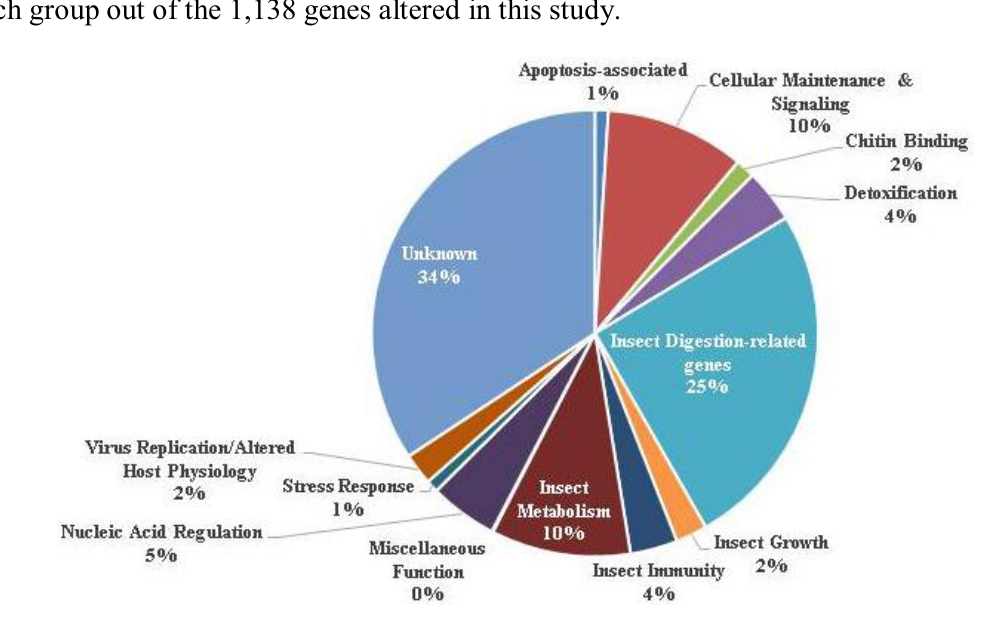
Figure 1. Global gene expression profile of the gut epithelium of Helicoverpa zea infected with HzSNPV. Percentages shown in the pie chart represent the percent of genes altered in each group out of the 1,138 genes altered in this study.